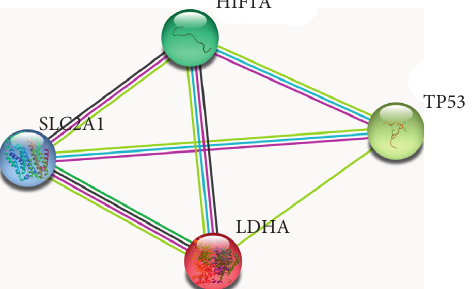
Figure 3: Protein-protein interaction network for HIF-1 α , GLUT1 (SLC2A1), TP53, and LDHA genes obtained through the STRING platform. It is noteworthy that all interactions observed between proteins (edges connecting the nodes) were experimentally char- acterized (pink line) and obtained from cured databases (light blue line). The other interactions observed: HIF-1 α and GLUT1 (SLC2A1); HIF-1 α and TP53; HIF-1 and LDHA; GLUT1 (SLC2A1) and TP53; GLUT1 (SLC2A1) and LDHA; LDHA and TP53 pre- sented confirmations based on analysis of text mining (yellow line) and coexpression (black line) observed computationally from transcript-transcript